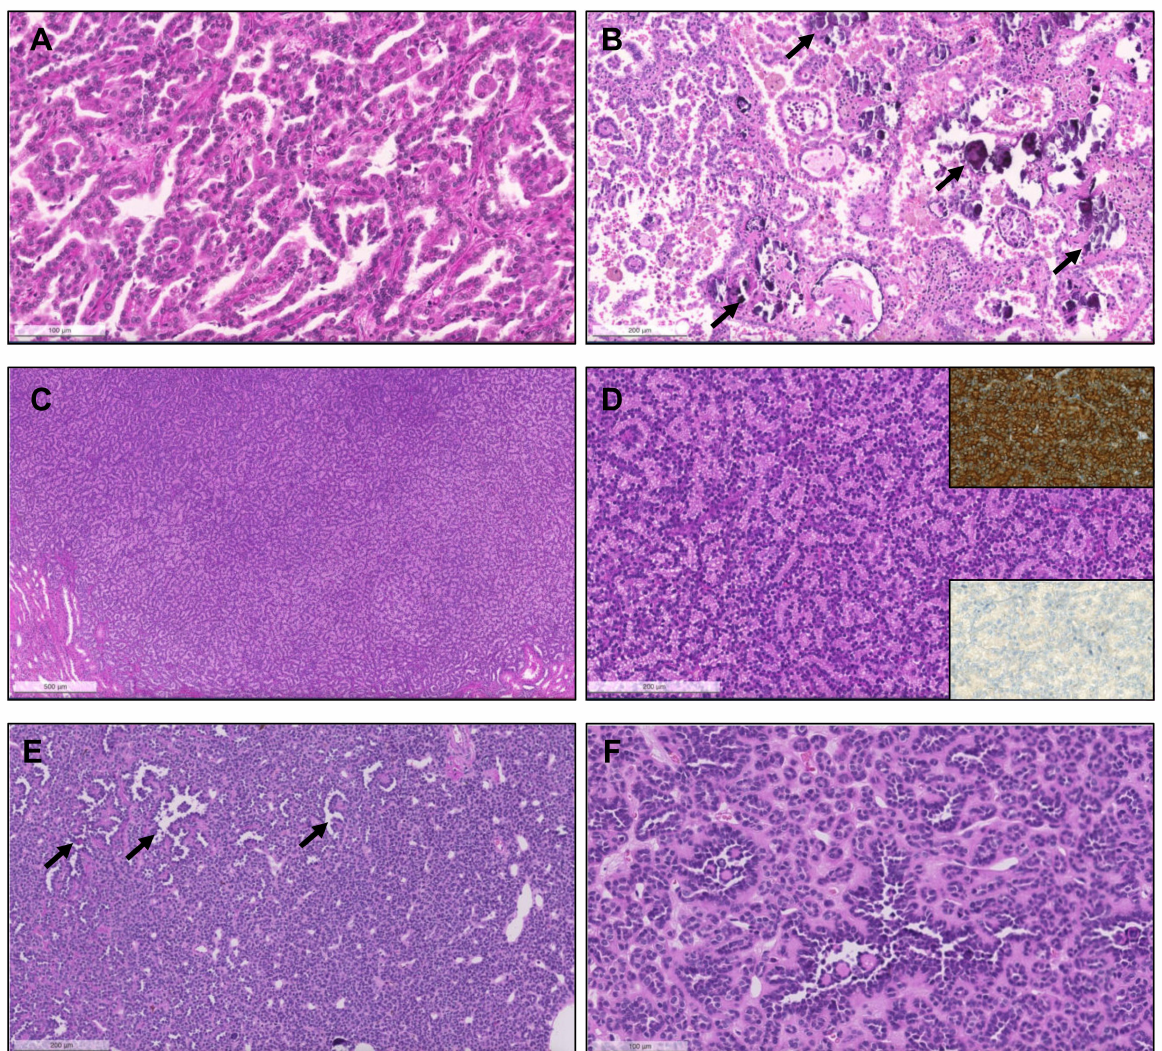
Figure 2. Patterns of pRCC type 1. ( A ) Classical features of pRCC type 1, with delicate papillae covered by cells with scant pale cytoplasm and nuclei arranged in a single layer. ( B ) Notice the frequent psammomatous calcifications (arrows) and macrophages filled with hemosiderin pigment; ( C ) Solid pattern of a pRCC in low power, mimicking metanephric adenoma. ( D ) At a higher power the papillary/tubulopapillary pattern is more evident, but is still challenging to distinguish from metanephric adenoma; ( E , F ) the correct diagnosis can be further confirmed with diffuse CK7 positivity (inset, upper right corner) and negativity for WT1 (inset, lower right corner). ( E , F ) Low and higher power aspects of a metanephric adenoma, showing a rather solid growth but with foci of papillary and tubular growth (( E , F ), arrows) with psammomatous calcifications, raising concern for a pRCC. The tumor was, however, diffusely positive for